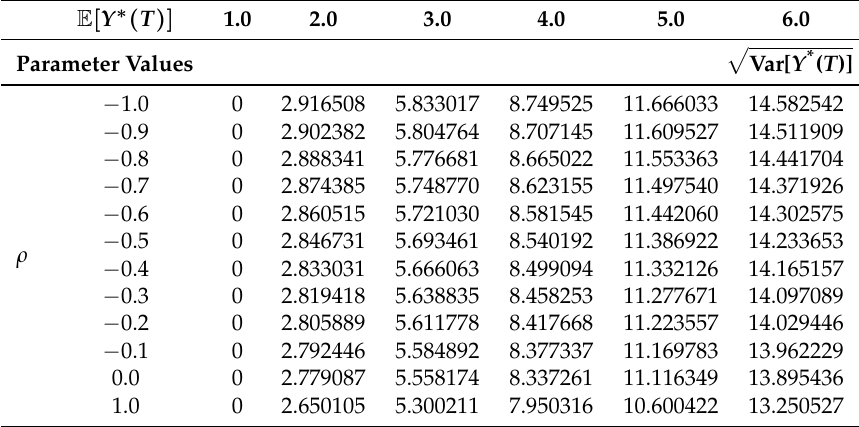
Table 3. The efficient frontier in the incomplete market with different ρ